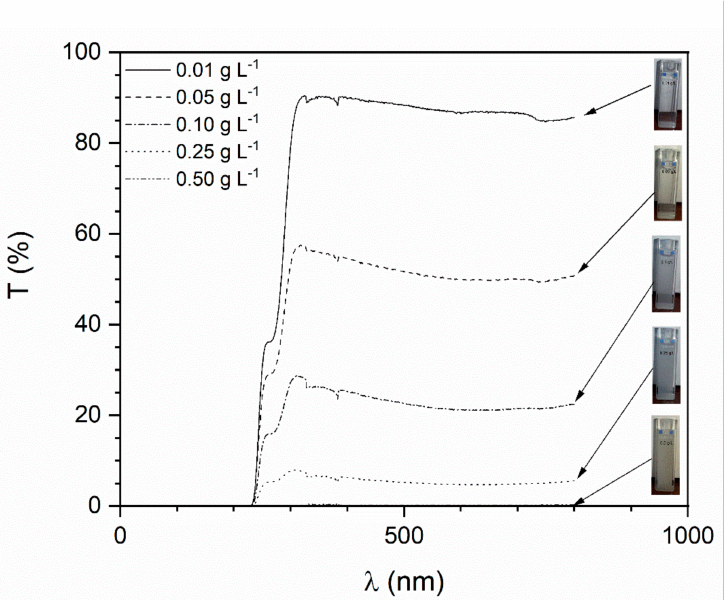
Figure 5. Degree of transmission for Pt@PC500 suspensions measured by UV/vis spectrometer (d cuvette = 1